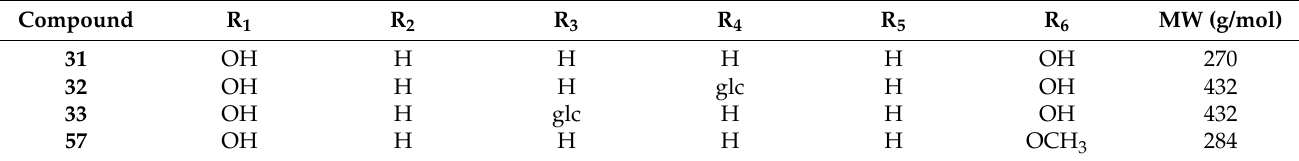
Table 5. Apigenin and